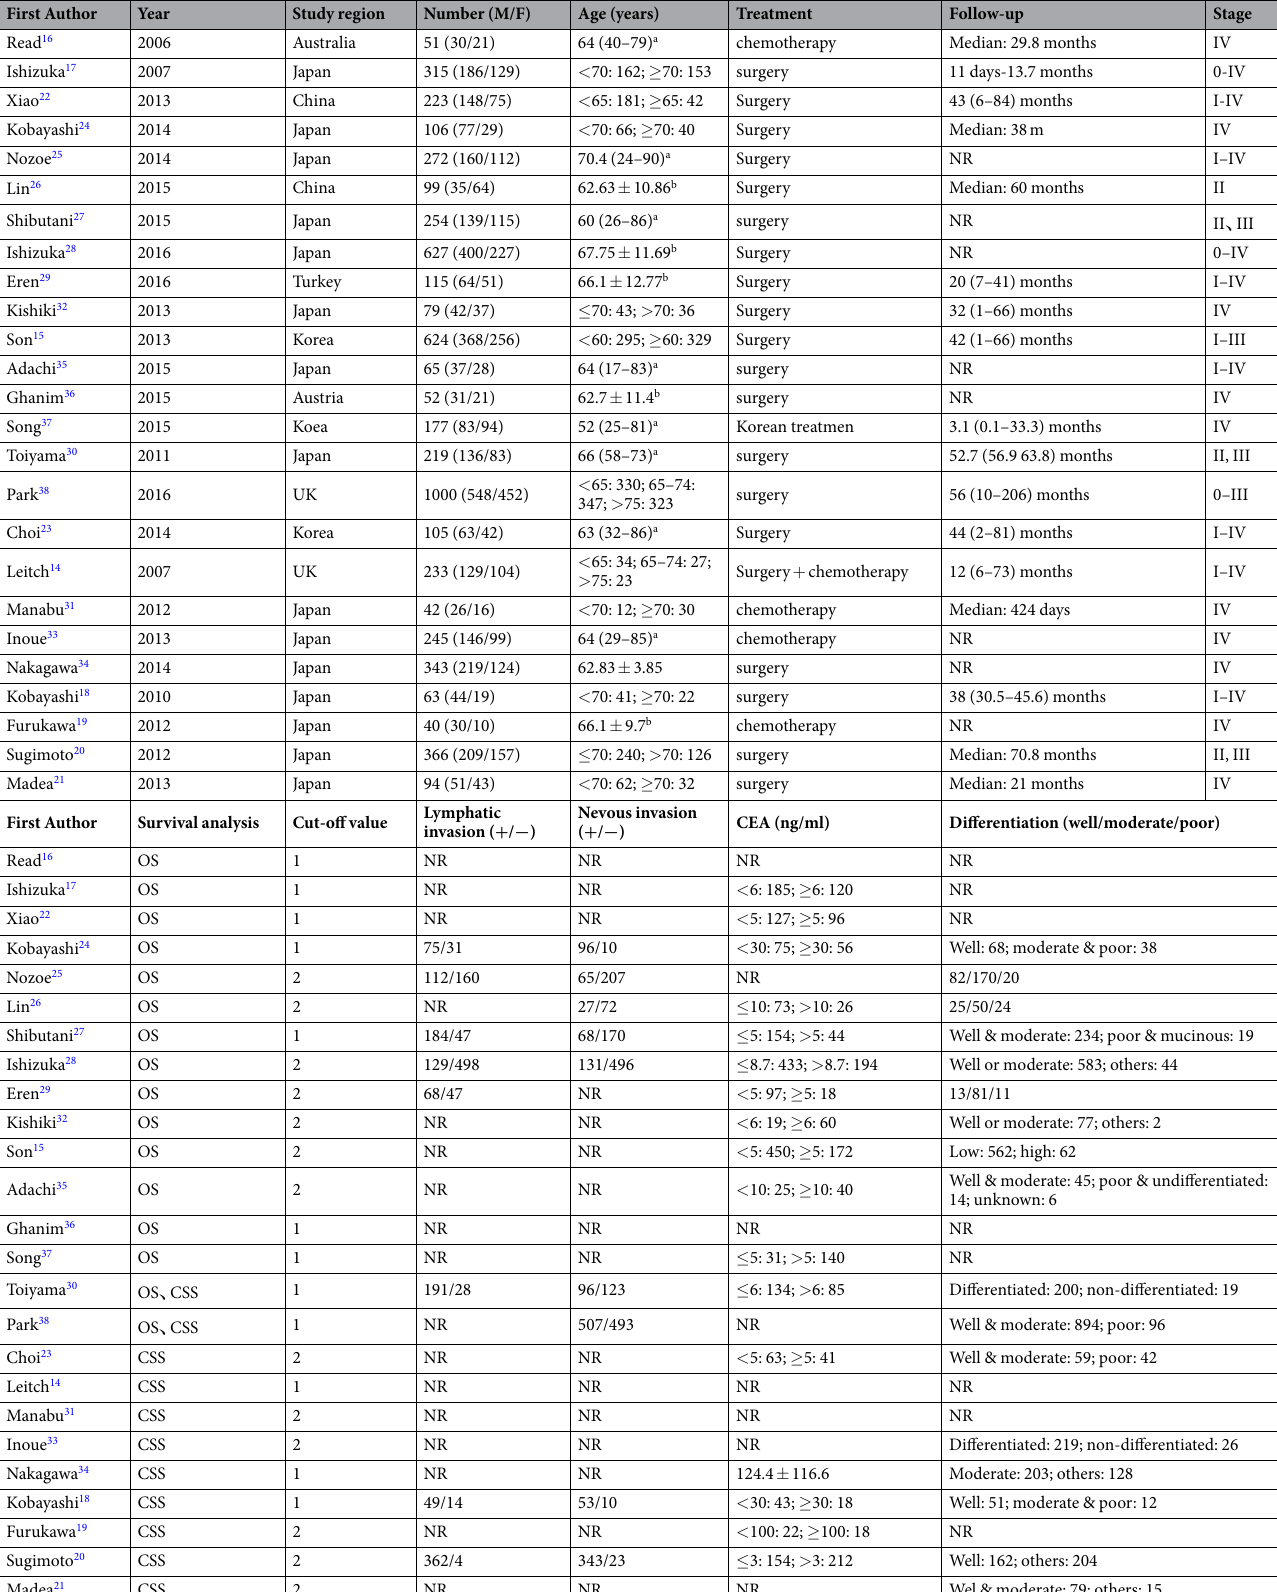
Table 1. Characteristics of included studies. NR = not reported, OS = overall survival, CSS = cancer-specific survival. a Mean (range). b Mean ±